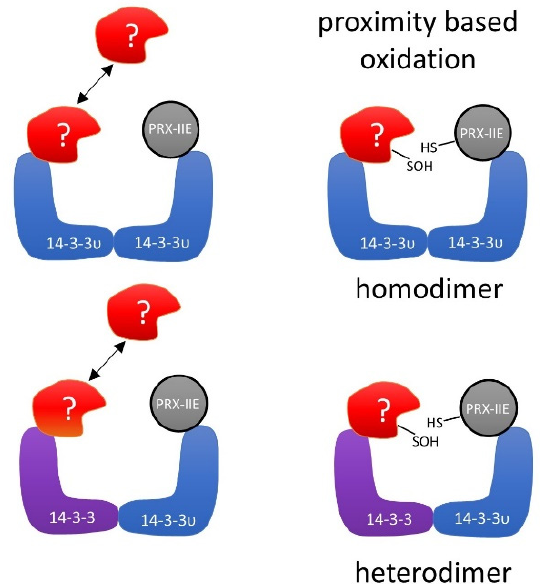
Figure 12. Schematic depiction of the hypothetical interaction between PRX-IIE and 14-3-3 υ . Bind- ing of oxidized PRX-IIE to 14-3-3 υ could induce the association of a third partner. The formation of such a complex could facilitate redox regulation, e.g., by proximity-based oxidation. The hypo- thetical assembly may involve homo- or heterodimers of 14-3-3 isoforms.